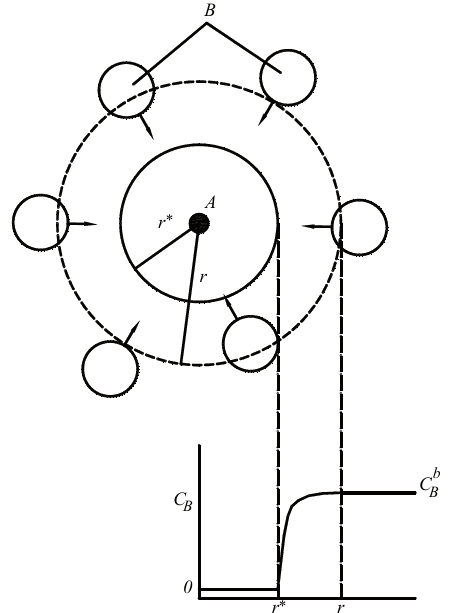
Figure 3. Model schematic for diffusion assisted electron transfer as developed in the authors’ previous